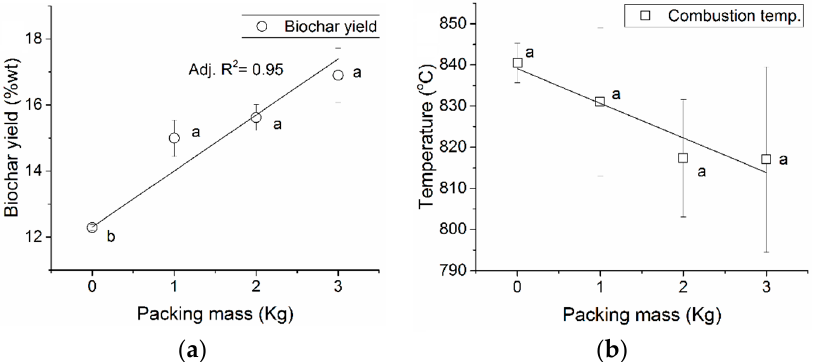
Figure 6. ( a ) Biochar yield and ( b ) combustion zone temperature using biomass with different biomass compactness. Airflow 20 lpm, 10% moisture content, avg. particle size 7 mm. Different letters on data points indicate significant differences ( p < 0.05).